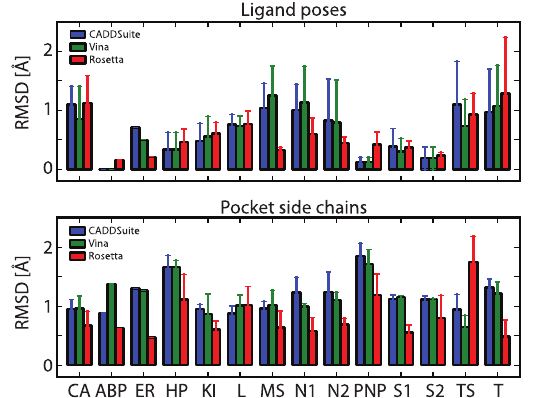
Figure 3. Differences of the ligand poses and pocket side chains in the benchmark designs compared to the crystal structures. The upper graph shows the average RMSDs and standard deviation between the ligand pose in the designs and in the crystal structures. The lower graph shows the average RMSD and standard deviation between the binding pocket side chain heavy atoms of designs and the corresponding crystal structure. The RMSDs are calculated after superimposing the structures using the backbone to make sure that the differences come from pocket/ligand pose differences only. RMSD from P OCKET O PTIMIZER CADDSuite score designs are plotted in blue, from P OCKET O PTIMIZER vina designs in green, and from Rosetta designs in red. Each point marks the average RMSD for all designs of a test case usign one score. The number of designs that contribute to a value depends on the number of mutations with a crystal structure, it is the square of this number (because each structure is used as a design scaffold for each mutation). Test cases are: